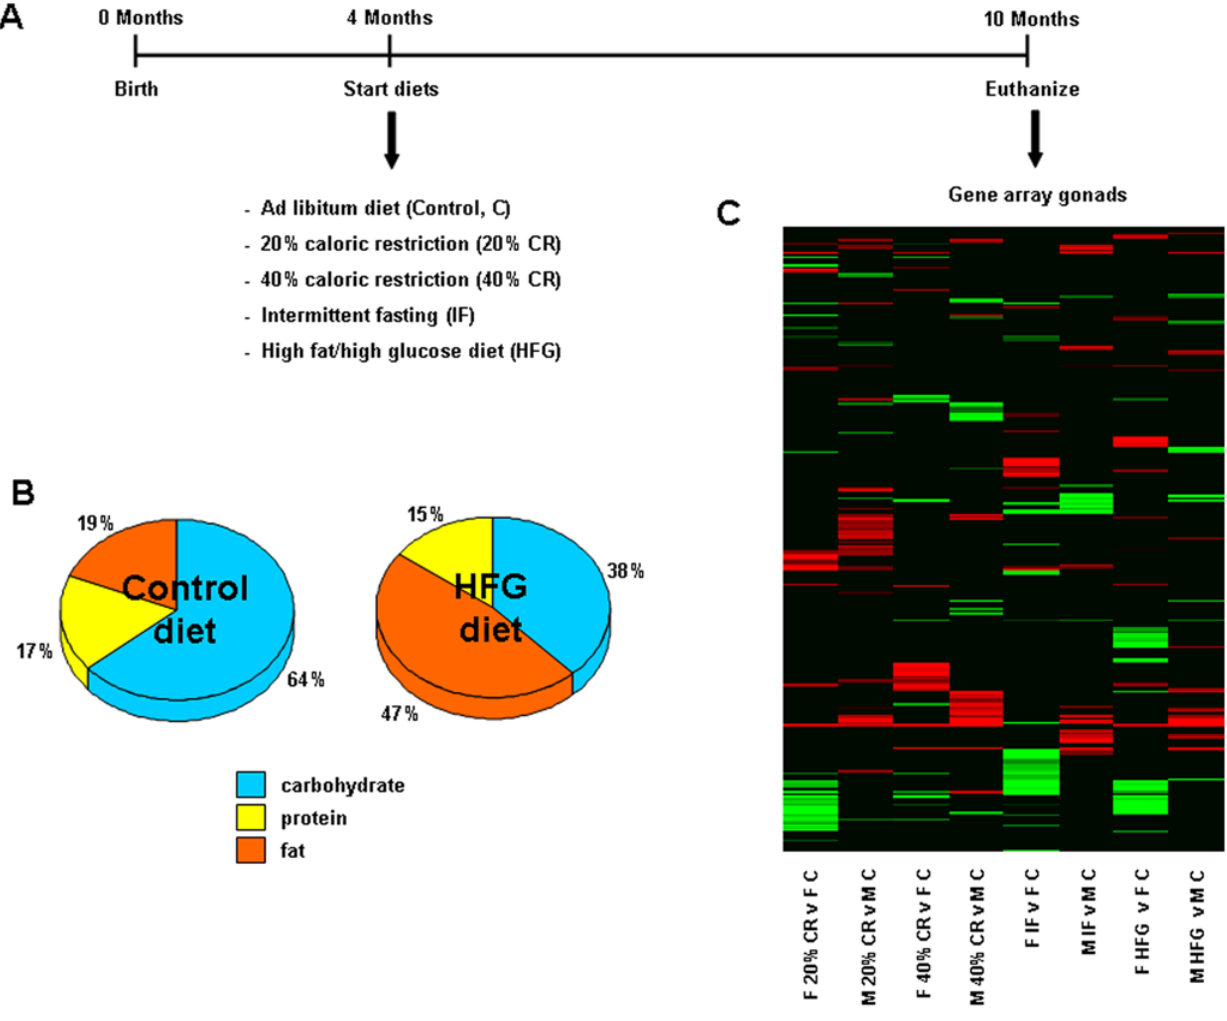
Figure 1. Experimental design, diet composition and heatmap of significantly altered gonadal genes. (A) The experimental timeline for this study. Four-month-old male and female rats were placed on one of 5 dietary regimes (control (ad libitum), 20% caloric restriction (CR), 40% CR, intermittent fasting (IF), or high fat/high glucose (HFG)). At 10 months of age, rats were euthanized and gonadal tissues were collected. A 17 K mouse gene array was performed and significant gene and pathway expression changes were quantified. (B) The relative proportions of the major nutritional groups in the control and high-fat/glucose (HFG) diets. (C) Regulatory heatmap of the significantly up-regulated (red) and down-regulated (green) genes in gonads collected from male and female rats on the different dietary regimes, compared to gonads collected from ad libitum